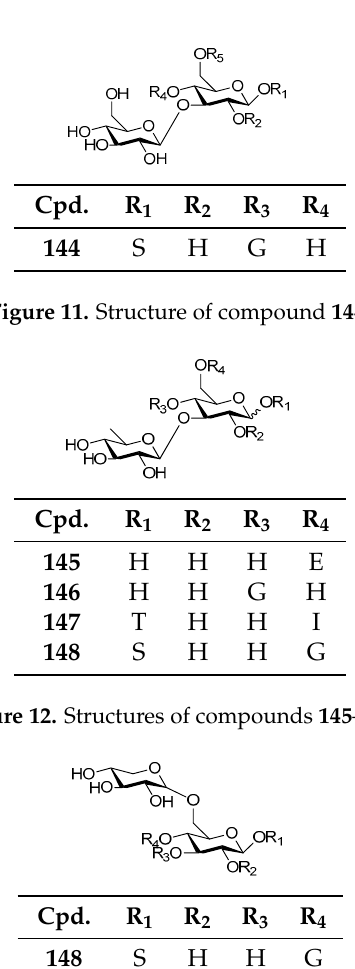
Figure 13. Structure of compound 148 .